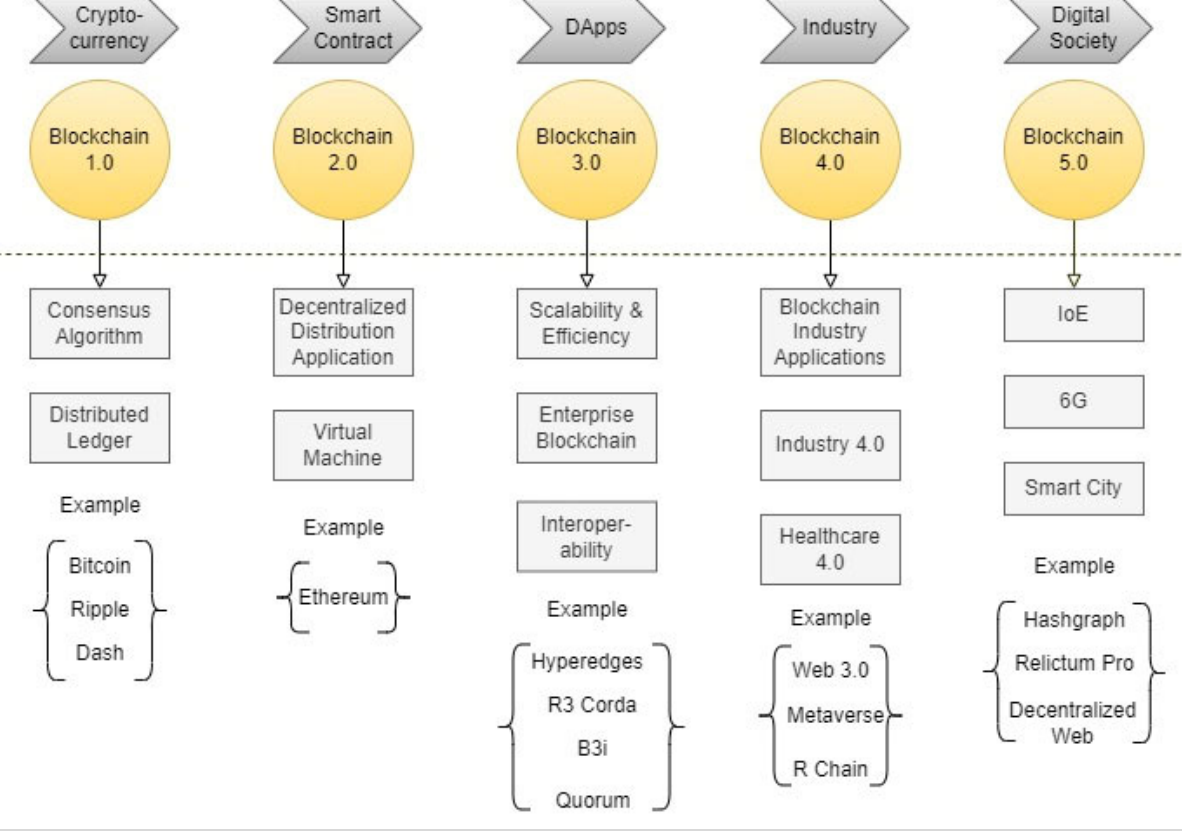
Figure 1. The scope of technical improvement in blockchain.